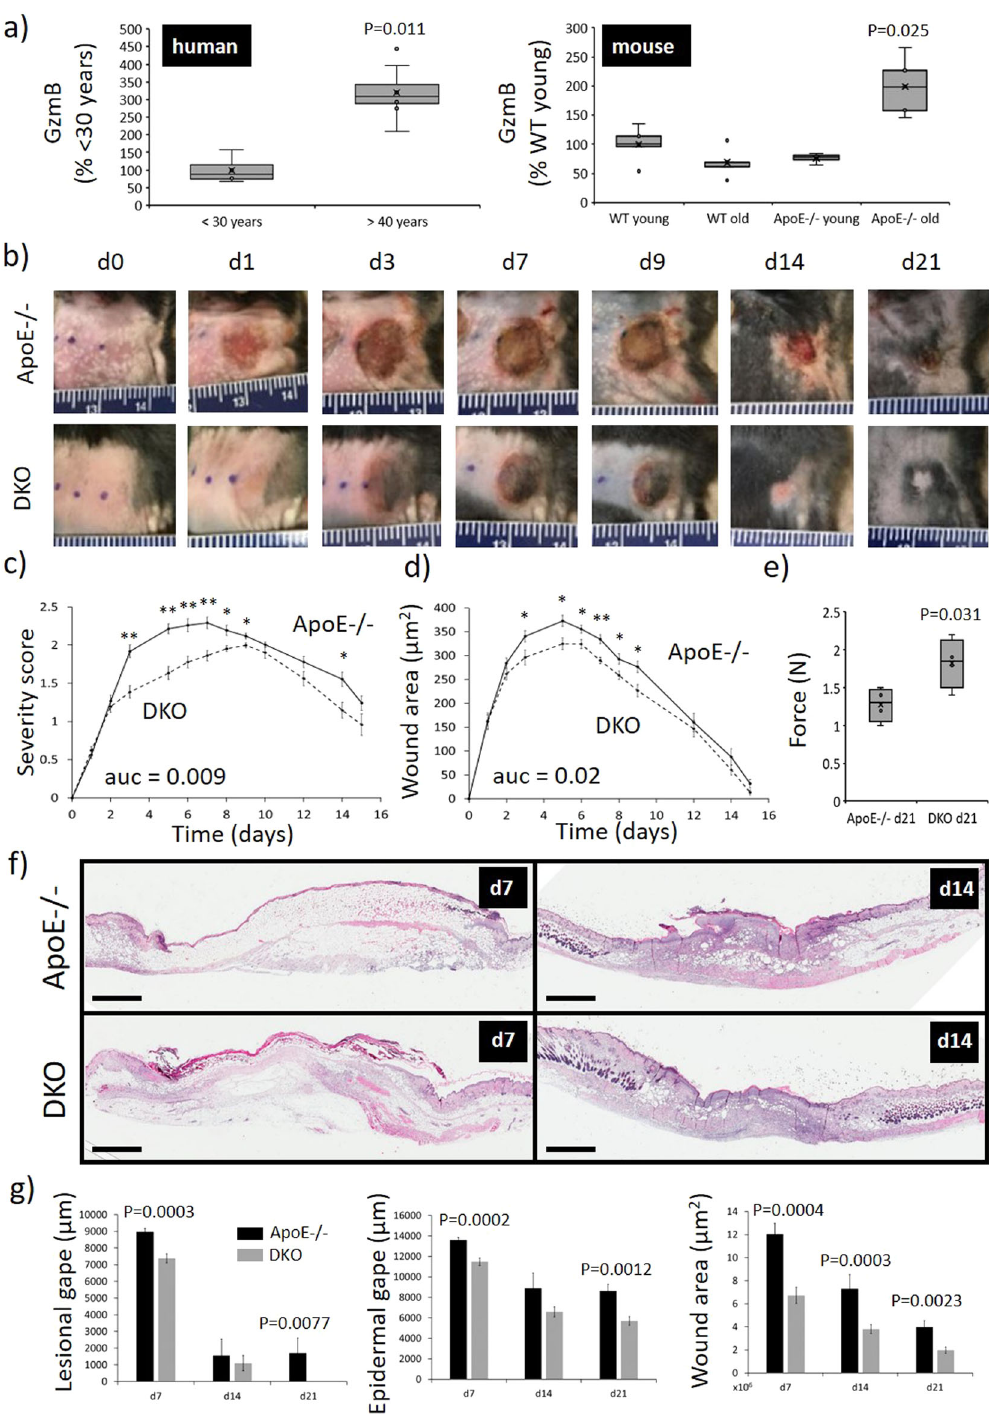
Fig. 2 Reduced wound severity in DKO mice PI. a Relative GzmB expression in human and mouse skin controls. b PI photos. c PI Severity score. d Macroscopic measure of wound area. Data in c , d presented as mean ± SEM, n = 6. * P < 0.05, ** P < 0.005. e Minimum wound breaking force at days 21, n ≥ 4 mice per group. f Representative images of H&E-stained mouse PI tissue. Scale bars = 1.5 mm. f Wound measurements calculated from the H&E-stained PI tissue. Presented as mean ± SEM, n =